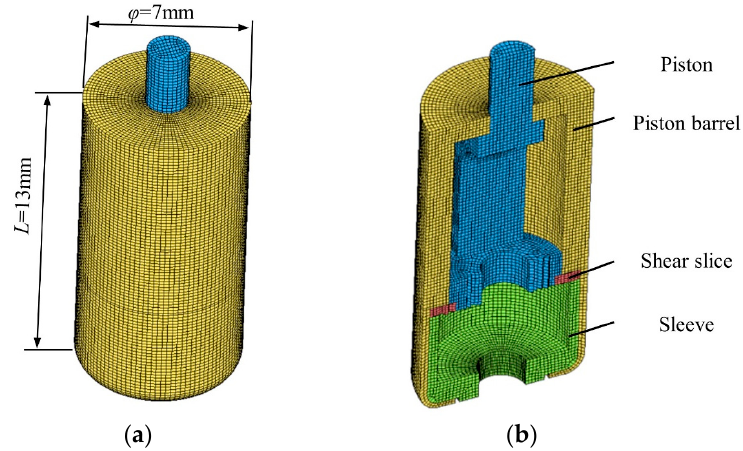
Figure 7. Finite element model of propellant actuator: ( a ) external view, ( b ) internal view.